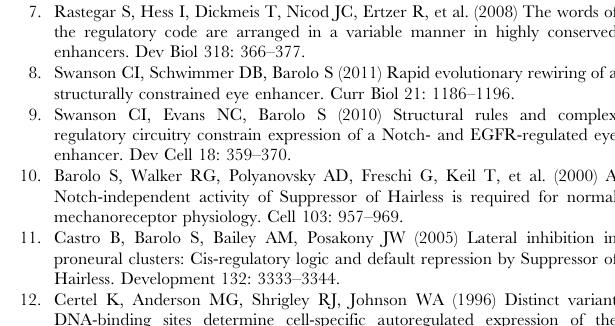
Table S1 Yeast one-hybrid screen using Fragment Y as bait. (PDF) Table S2 Yeast one-hybrid screen using Fragment X as bait. (PDF) Text S1 Supplemental Methods.